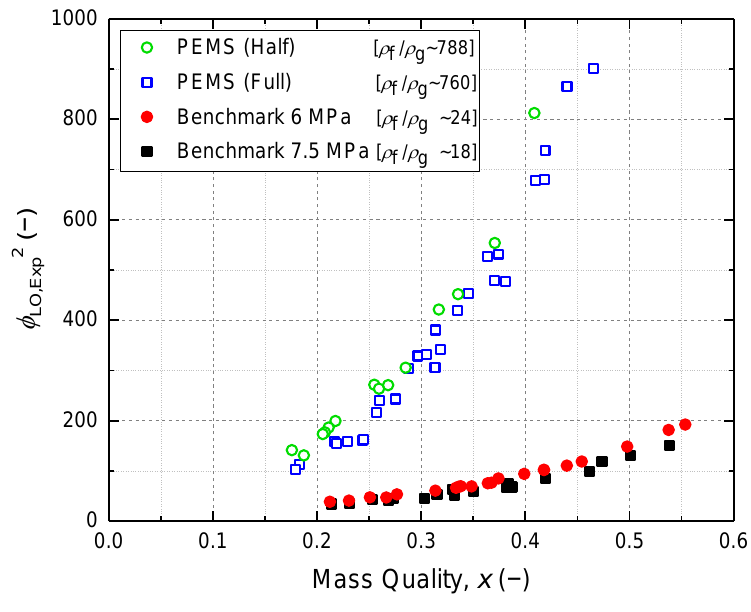
Figure 5. Dependency of mass quality on two-phase pressure drop multiplier.